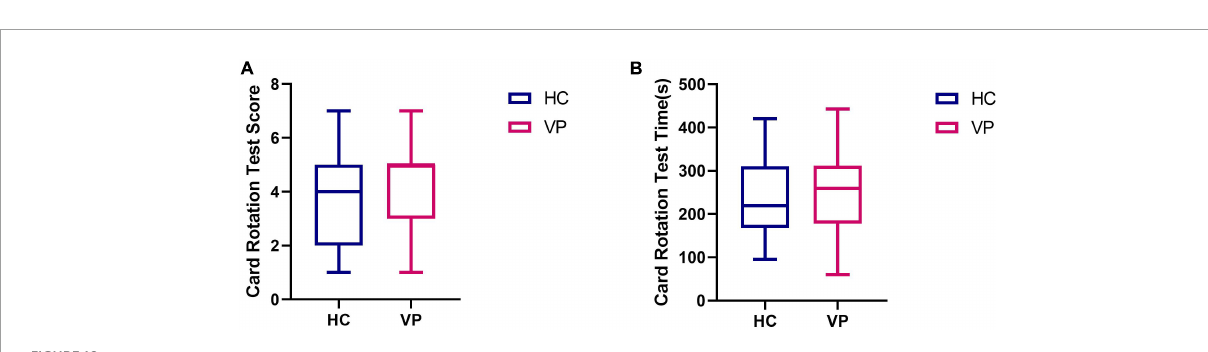
FIGURE12 Comparison of card rotation test indexes between VP and HC. (A) Score. (B) Time (s). The upper and lower lines represent the 95th and 5th percentiles, respectively, and the horizontal line within the box is the median. VP, patients with vertigo; HC, healthy